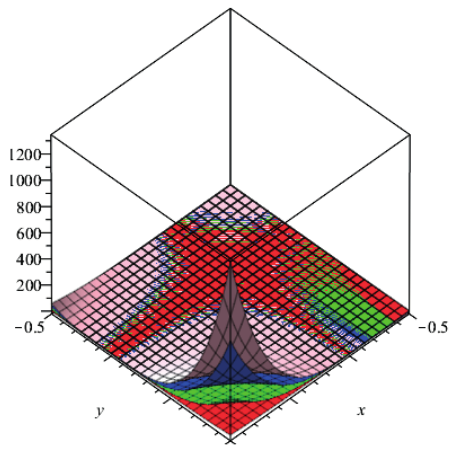
Table 2: The vertex partition of set of D